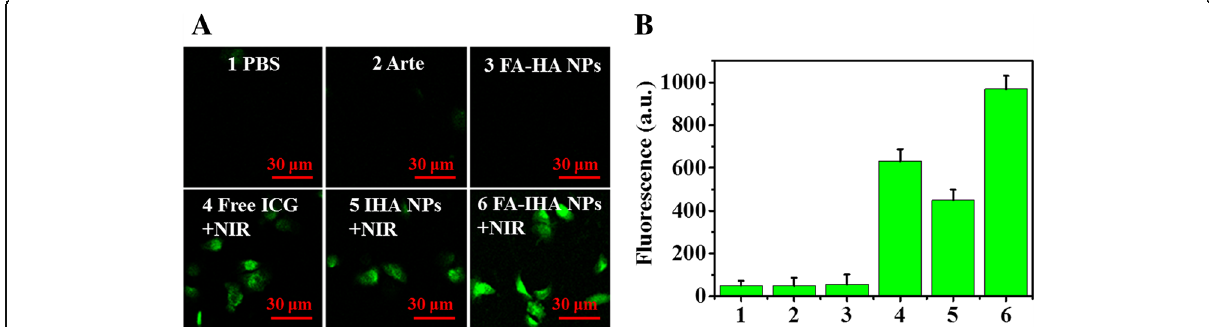
Fig. 6 a Fluorescence images of ROS production in cancer cells treated with various drugs, and b corresponding fluorescent intensity: (1) PBS, (2)